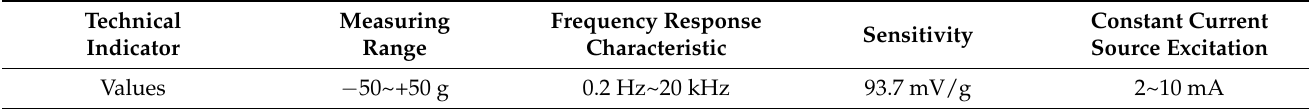
Table 2. Parameters of the IEPE